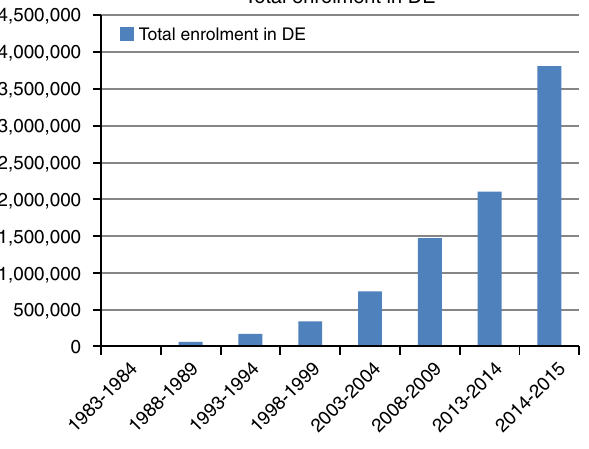
Figure 1. Trend of